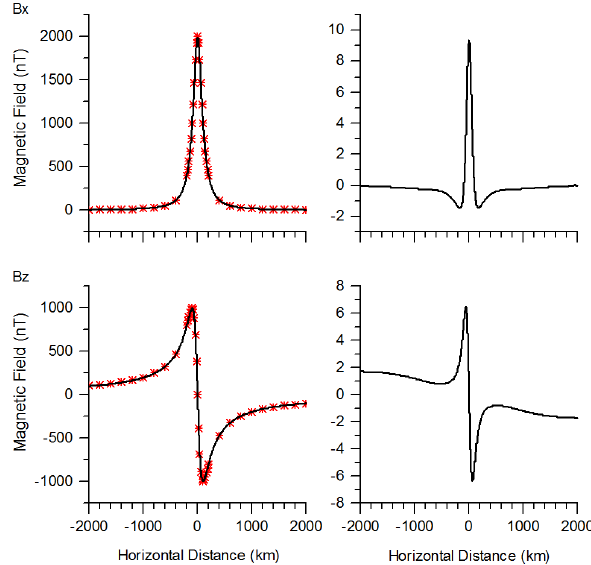
Fig. 2. The magnetic field components at z = 0 and their differences from theoretical values for the free space case. The red symbols are the exact solution and the black line is the FEM solution. The graphs in the right column are the difference between the exact solution and the FEM model. The period is 300s.